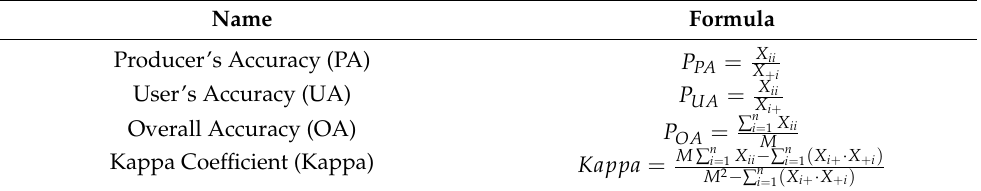
Table A2. Formulas of the selected accuracy verification indicators of different classifiers.